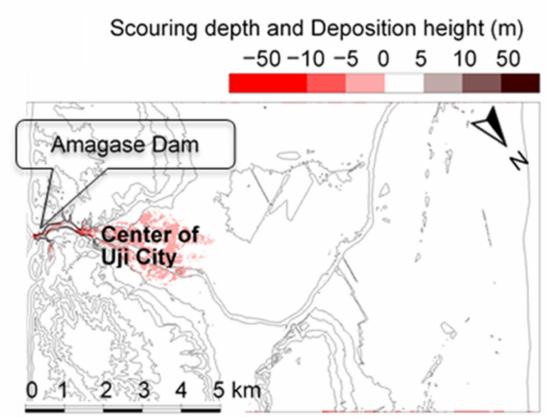
Figure 14. (Case–1). Topography change, 10 min after the start of the calculation.